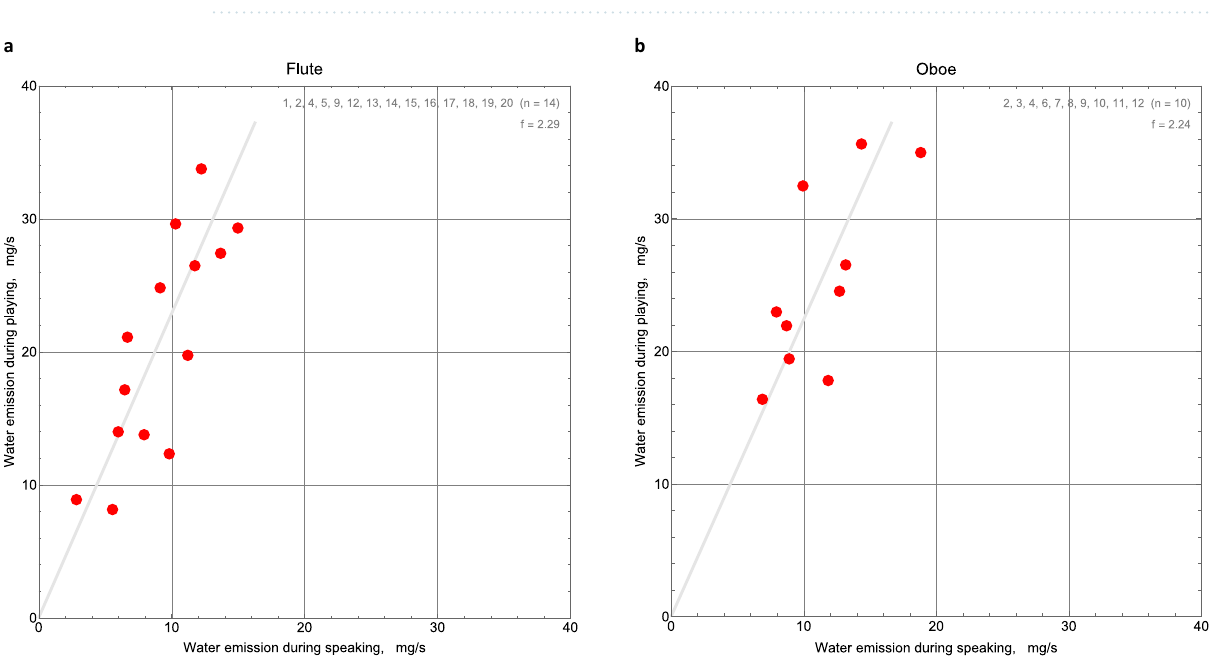
Figure 8. Water emission rates (unit: mg/s) during flute ( a ) and oboe ( b ) playing vs. during speaking. The regression lines have virtual identical slopes of 2.2 for both groups, i.e., water emission generally doubles from speaking to instrument